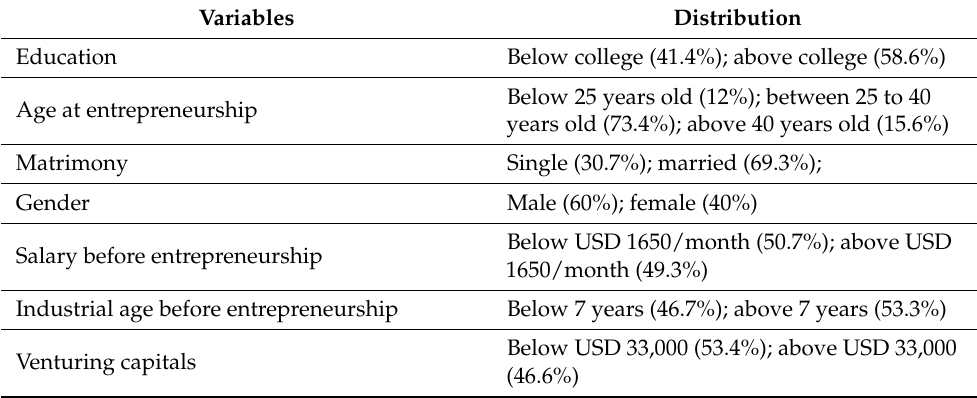
Table 2. Descriptive Profile of respondent